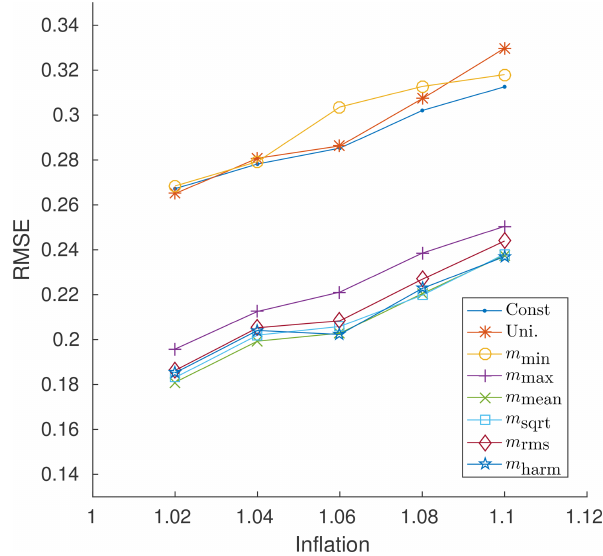
Figure 1. Generalized mean oracles for Lorenz’96. Comparison of the various m -based multivariate localization techniques with that of standard univariate localization and constant “best radius” local- ization. Results were obtained using the Lorenz’96 model over the assimilation cycles [ 100 , 1100 ] and were run for various values of the inflation